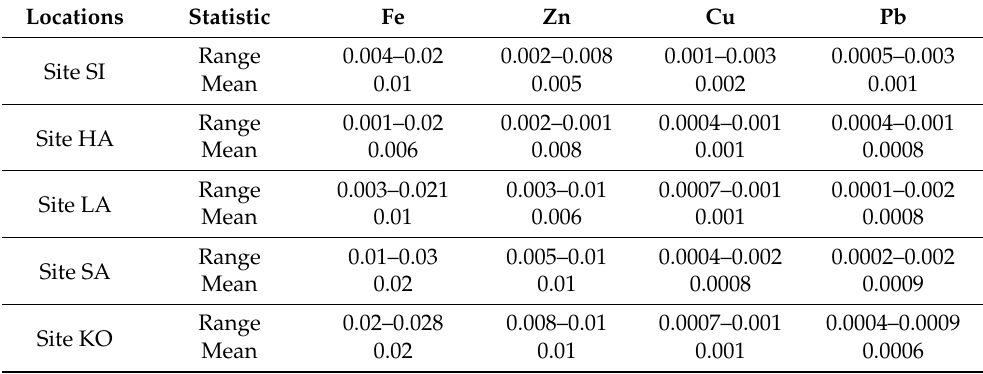
Table 3. MDI index of heavy metals in roof-harvested rainwater.